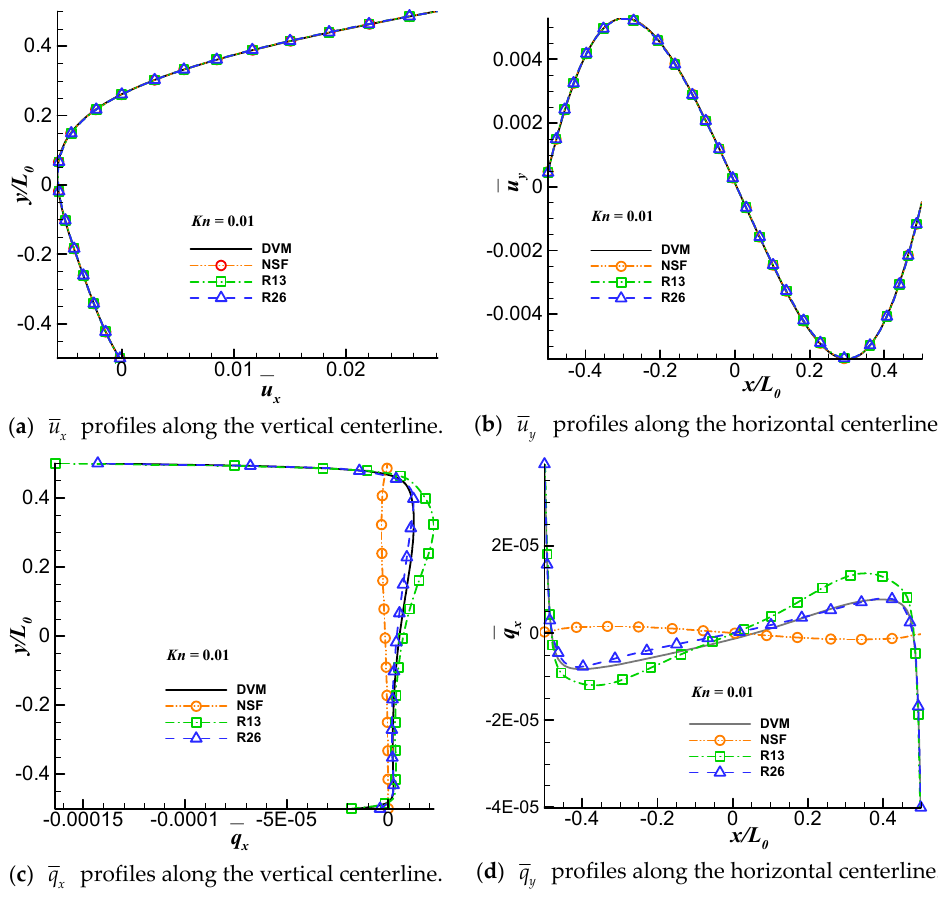
Figure 5. The simulation results of the cavity flow at Kn = 0.01.